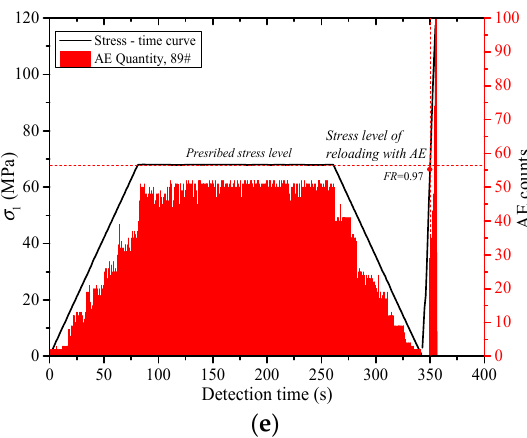
Figure 9. Stress–time–AE curves in uniaxial cyclic loading and unloading test of granite under different loading rates ( σ A = 0.7 σ c ). ( a ) l r = 0.001 mm/s; ( b ) l r = 0.005 mm/s; ( c ) l r = 0.01 mm/s; ( d ) l r = 0.05 mm/s; ( e ) l r = 0.1 mm/s.